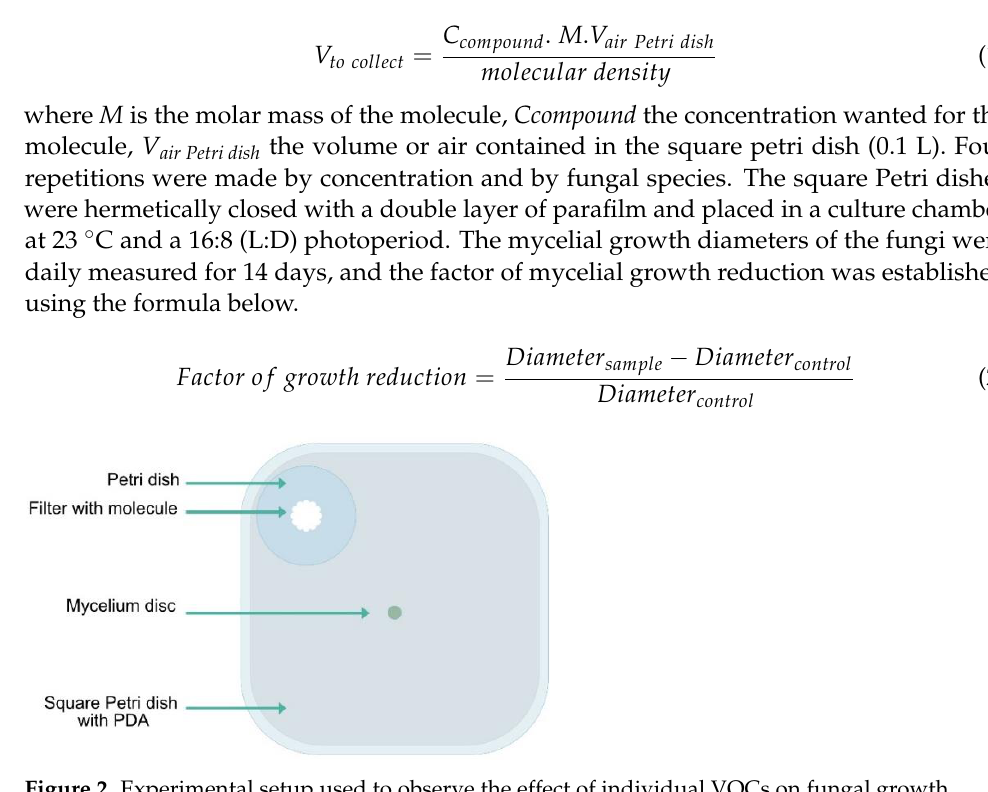
Figure 2. Experimental setup used to observe the effect of individual VOCs on fungal growth. Table 1. List of individual VOCs and fungal species against which they were